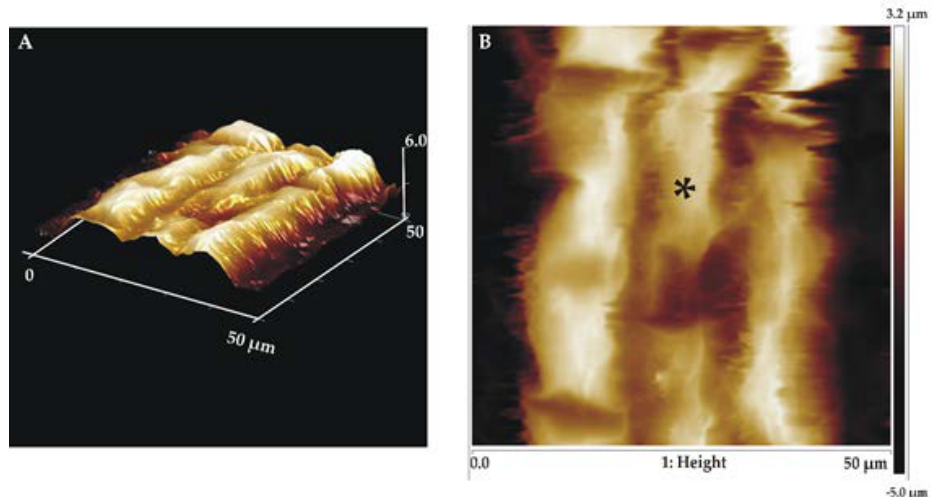
Figure 4. Atomic force microscopy (AFM) imaging of the surface of the root elongation zone cells at high resolution. Topography of a small area (50 × 50 µ m) of the root elongation zone using contact mode in fluid. Friction image of a few cells of the root elongation zone of Col-0 ( A ); height images of the same zone of Col-0 indicating the location where force curves were obtained ( B ). * indicates the location where force curves were obtained. Table 1. Cell walls apparent elastic modulus measured in cells of the elongation zone of roots